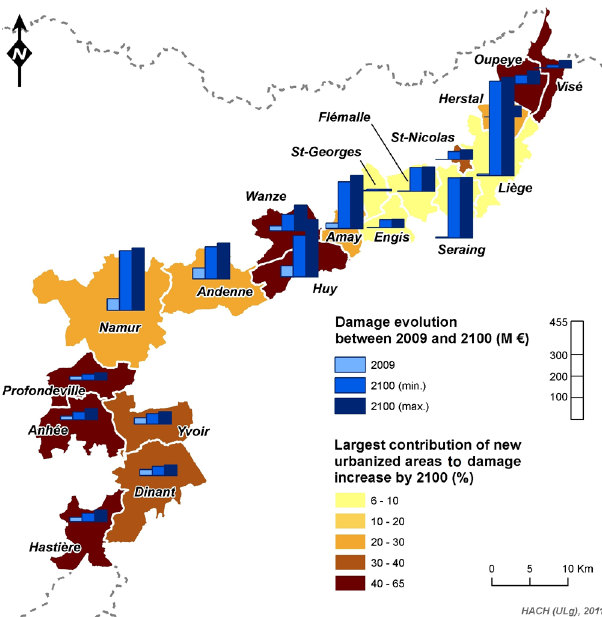
Fig. 15. Flood damage evolution between 2009 and 2100 for the 100yr flood according to the wet climate scenario, and relative contribution of future urbanization to damage by municipality.